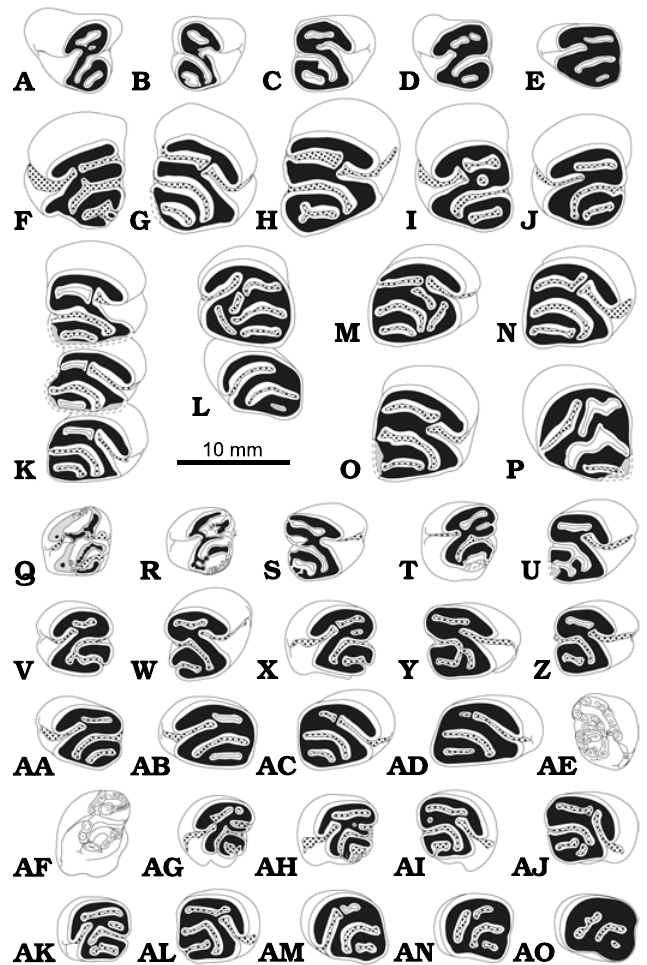
Fig. 3. Occlusal pattern of upper cheek teeth of the beaver Steneo fiber de- pereti Mayet, 1908, from the early Late Miocene locality Hammer schmiede (Bavaria, Germany), local stratigraphic levels HAM 5 and HAM